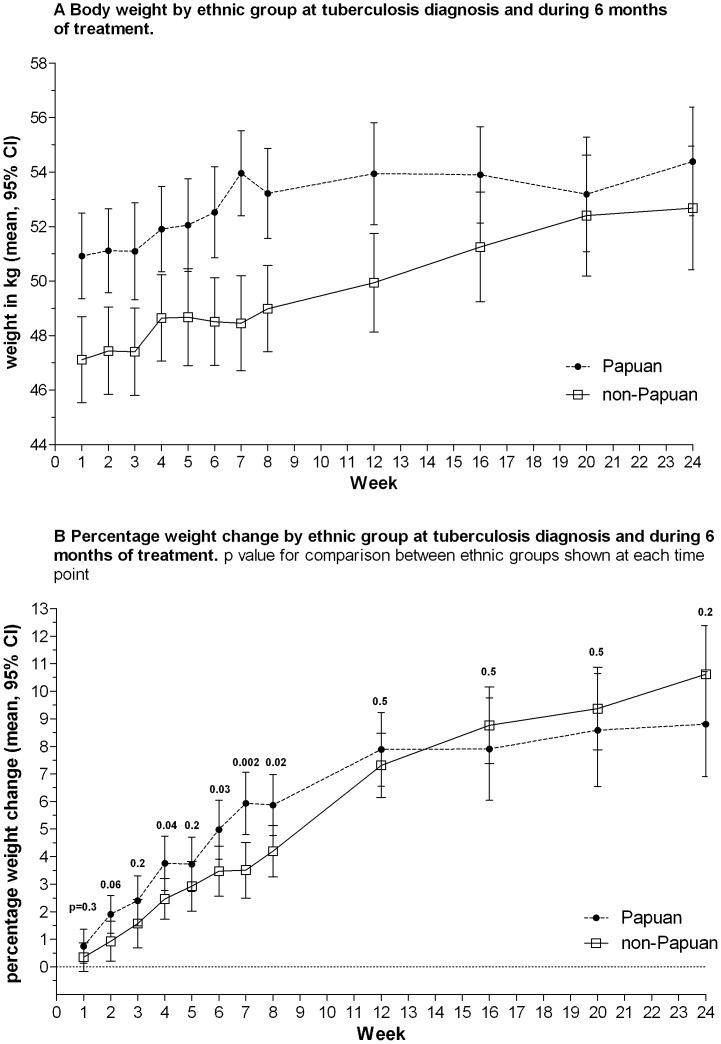
Weight according to ethnic group.A. Body weight by ethnic group at tuberculosis diagnosis and during 6 months of treatment. B. Percentage weight change by ethnic group at tuberculosis diagnosis and during 6 months of treatment. p value for comparison between ethnic groups shown at each time point